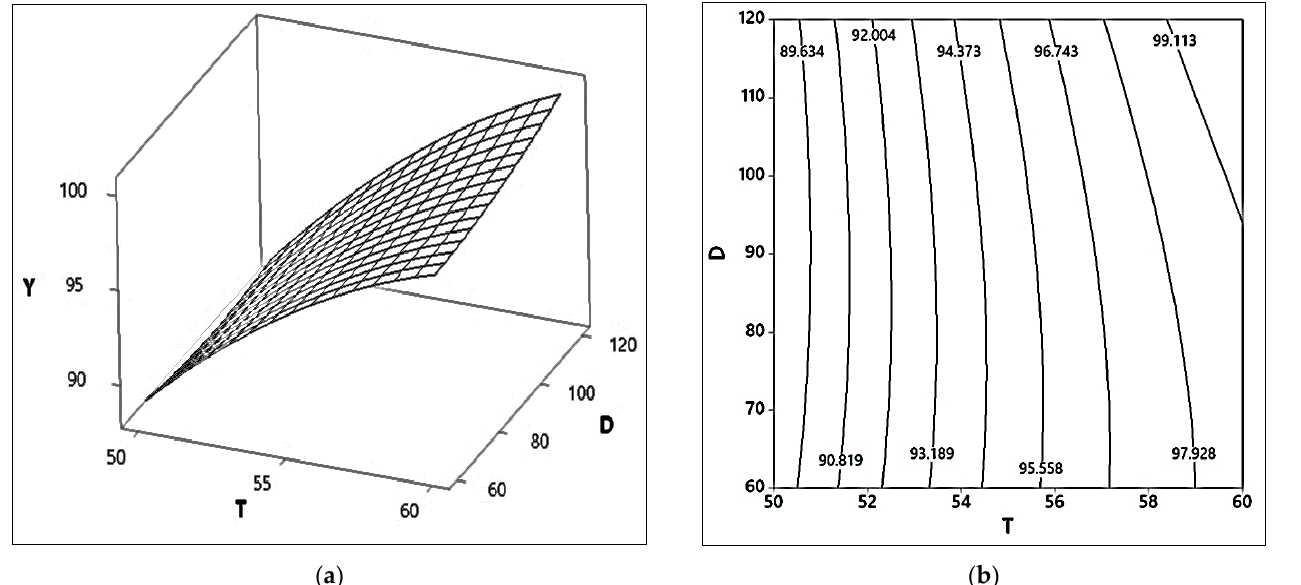
Figure 14. Interaction effect of the reaction temperature (T) and reaction time (D) on the FAME yield (Y) of the transesterification process. ( a ) A 3D response surface plot of Y (%) vs. T (°C) and D (minutes). ( b ) 2A D contour plot between T (°C) and D (minutes).